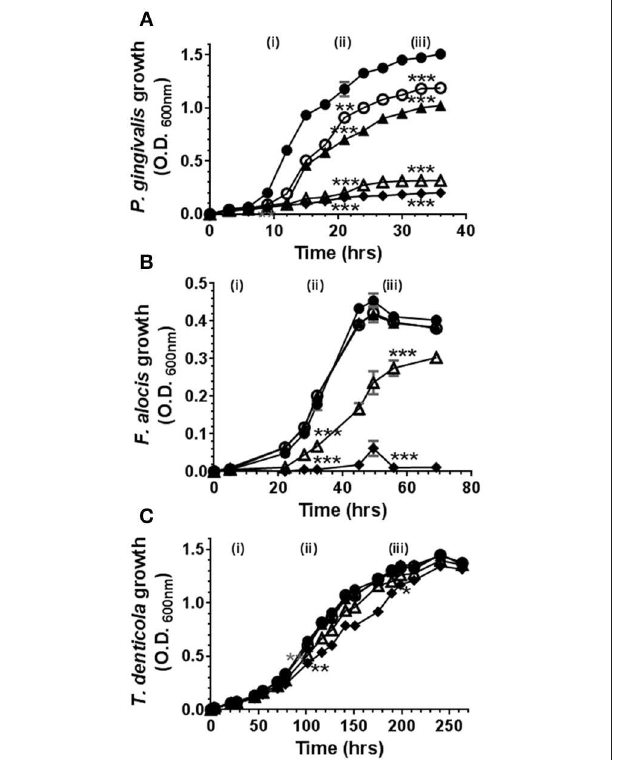
FIGURE 1 | High doses of cannabidiol suppress the growth of (A) P. gingivalis and (B) F. alocis but not (C) T. denticola . P . gingivalis , F . alocis, and T . denticola were each cultured under anaerobic conditions in the presence or absence of CBD, at the doses noted below, and growth monitored by densitometry. CBN and THC exhibited similar anti-bacterial activities ( data not shown ). Data represent the mean ± SEM of three biological replicates. (cid:8) , (cid:13) , N , △ , and (cid:7) represent 0.0, 0.1, 1.0, 5.0, and 10.0 µ g/ml CBD, respectively. * / ** / *** p ≤ 0.5/0.01/0.001 respectively, as determined by ANOVA at early-, mid-, and late-log growth